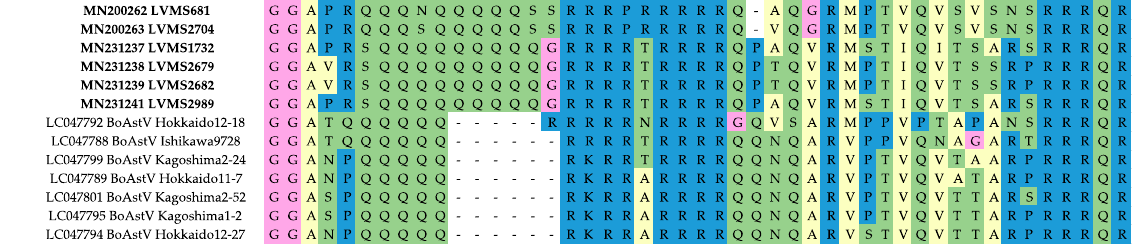
Figure 3. Amino acid alignment of unclassified strains. The amino acid alignment from position 44 to 89 of the capsid protein (LVMS2704 used as reference) is shown.